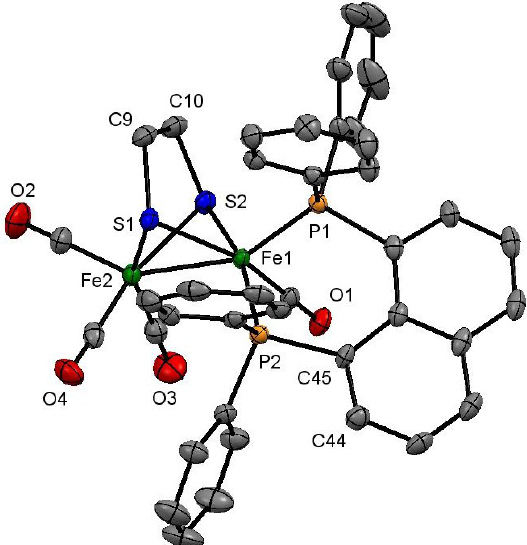
Figure 2. Molecular structure of one independent molecule of [Fe 2 (CO) 4 ( κ 2 -dppn)( µ -edt)] ( 3 ) showing 50% probability thermal ellipsoids. Hydrogen atoms are omitted for clarity. [Selected bond distances (Å) and angles ( ◦ ): Fe(1)–Fe(2) 2.5377(8), Fe(1)–P(1) 2.1756(9), Fe(1)–P(2) 2.1970(9), Fe(1)–S(1) 2.2478(9), Fe(1)–S(2) 2.2475(9), Fe(2)–S(1) 2.2526(9), Fe(2)–S(2) 2.2575(9); P(1)–Fe(1)–Fe(2)